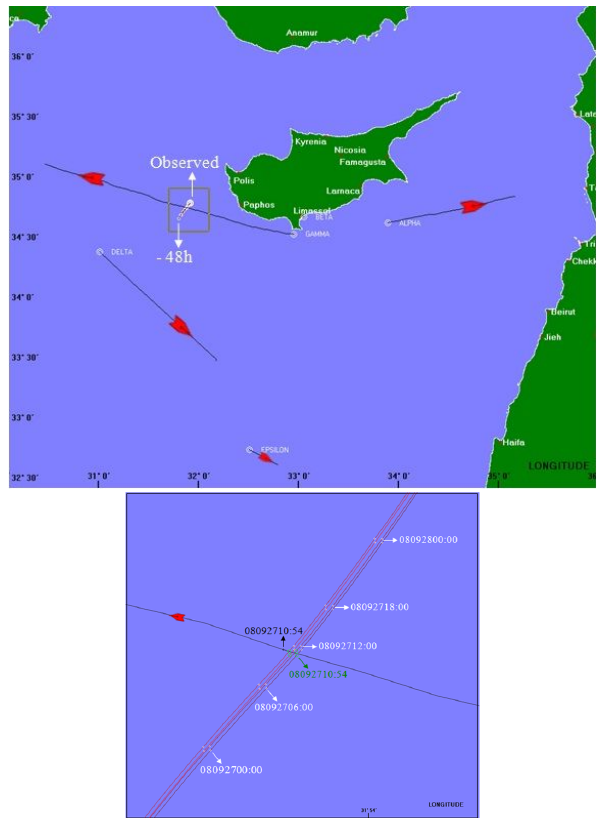
Fig. 4. (a) Ship tracks from 27–28 September 2008 as identified by AIS, together with the hindcast track of the slick observed on the early morning of the 28 September 2008. (b) Shows an enlarge- ment of the area around the crossing between the ship track and the predicted hindcast trajectories of the oil drift shown in (a)